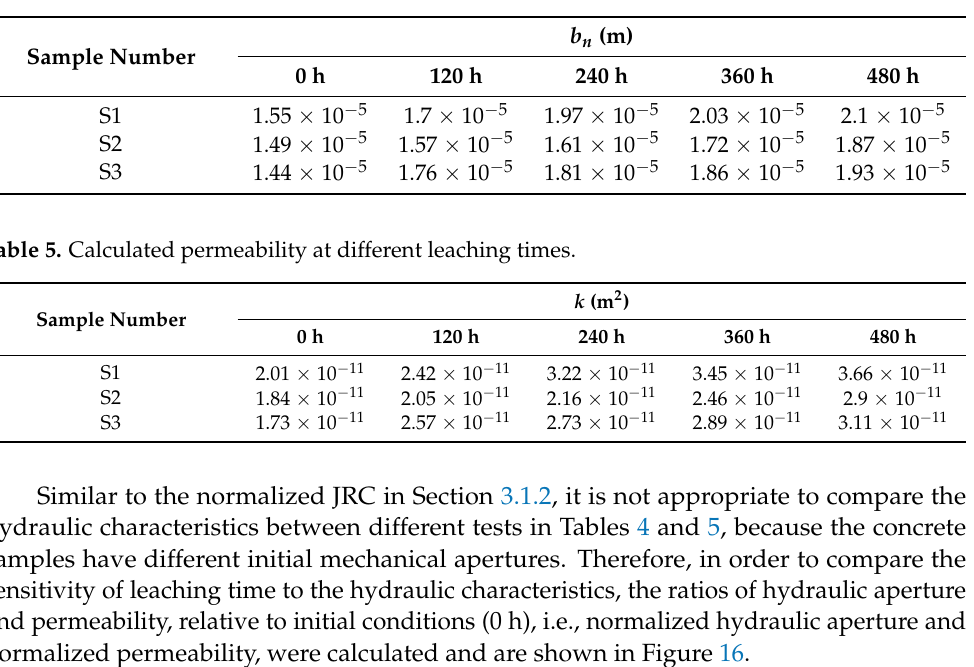
Table 4. Calculated hydraulic aperture at different leaching times.